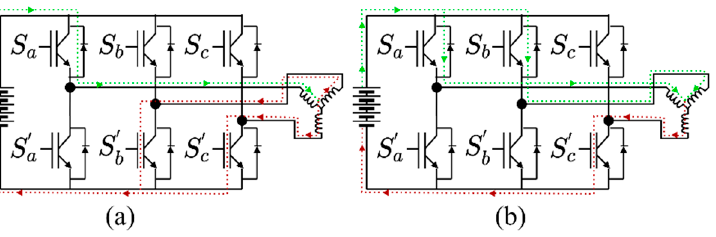
Figure 7. The current flow paths: ( a ) during V1 voltage sector, ( b ) during V2 voltage sector.